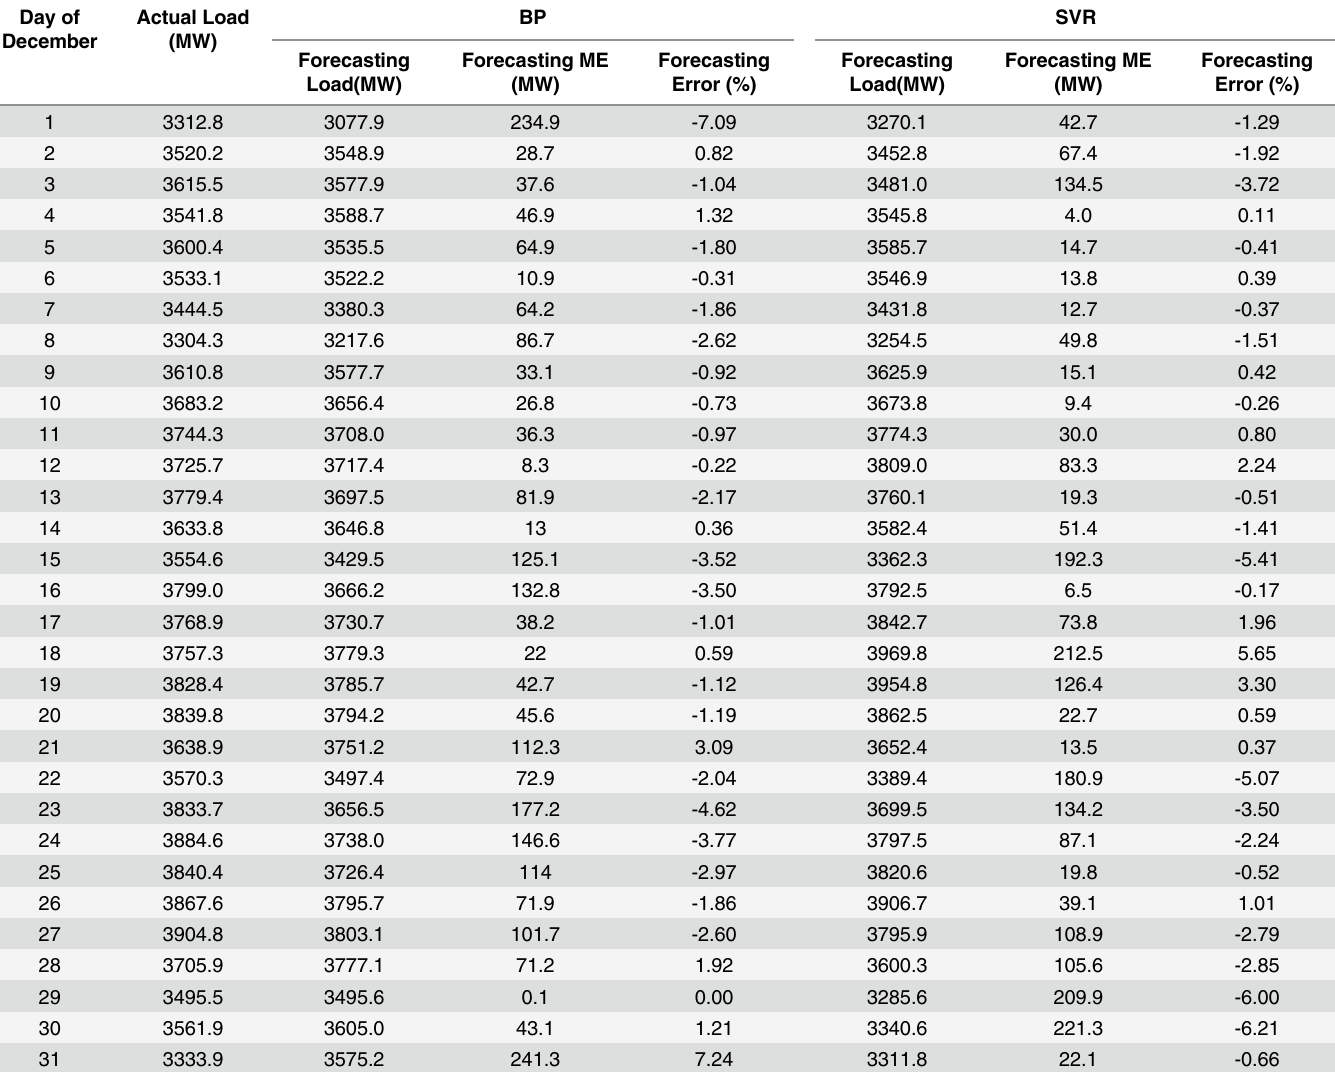
Table 2. Forecasting